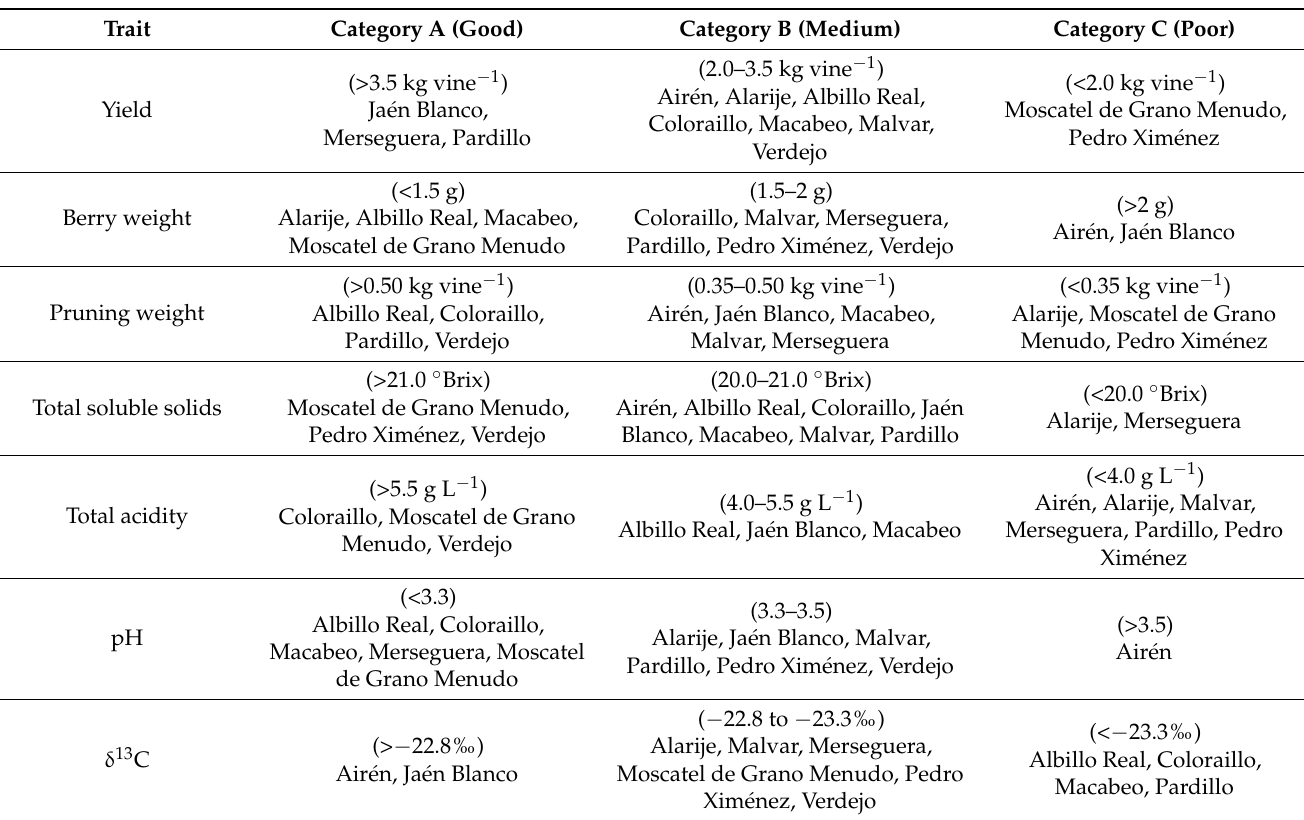
Table 7. Classification of varieties into three categories based on their response to drought according to the seven parameters considered in the PCA: yield, berry weight, pruning weight, total soluble solids, total acidity, pH, and δ 13 C. Category cut-offs were arbitrarily chosen (adapted from